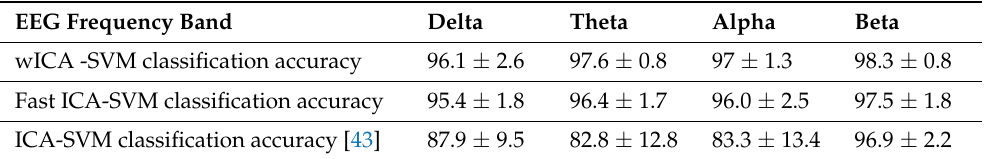
Table 3. The SVM classification accuracy for each EEG frequency